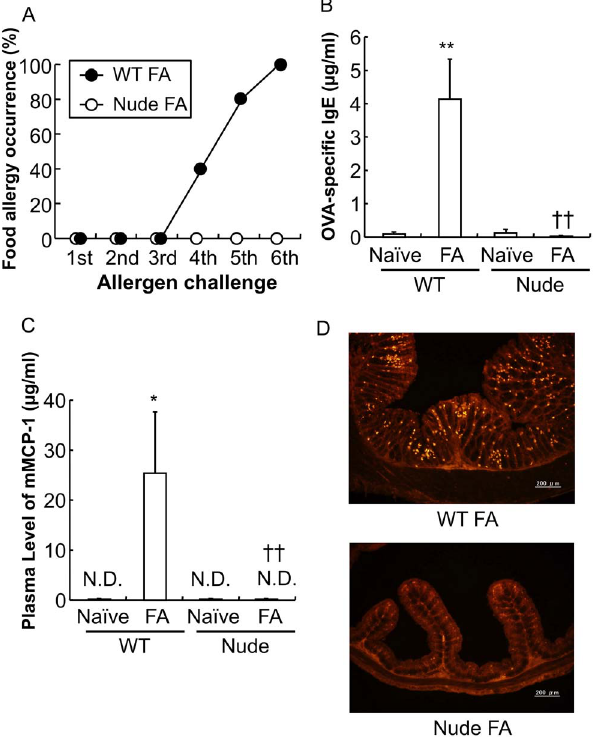
Figure 4. Induction of food allergy in athymic nude mice. A : The occurrence of allergic diarrhea in wild-type (WT) FA mice and nude FA mice after each oral OVA challenge is shown (n=5 mice per group). B : The level of OVA-specific IgE in the plasma of WT naı¨ve mice, WT FA mice, nude naı¨ve mice and nude FA mice is shown. The level of OVA- specific IgE in the plasma was determined using an ELISA kit. ** P , 0.01 vs. WT naı¨ve mice, {{ P , 0.01 vs. WT FA mice ( n =3–5 mice per group). C : The level of mMCP-1 in the plasma of WT naı¨ve mice, WT FA mice, nude naı¨ve mice and nude FA mice is shown. The level of mMCP-1 in the plasma was determined using an ELISA kit. * P , 0.05 vs. WT naı¨ve mice, {{ P , 0.01 vs. WT FA mice ( n =3–5 mice per group). D : The proximal colon of WT FA mice and nude FA mice after the 6th oral OVA challenge